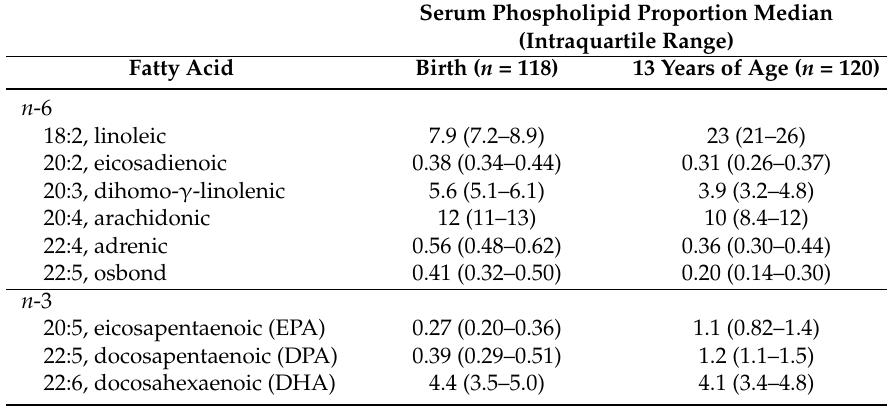
Table 3. Fatty acid proportions (% of total fatty acids) in serum phospholipids at birth and at 13 years of age.